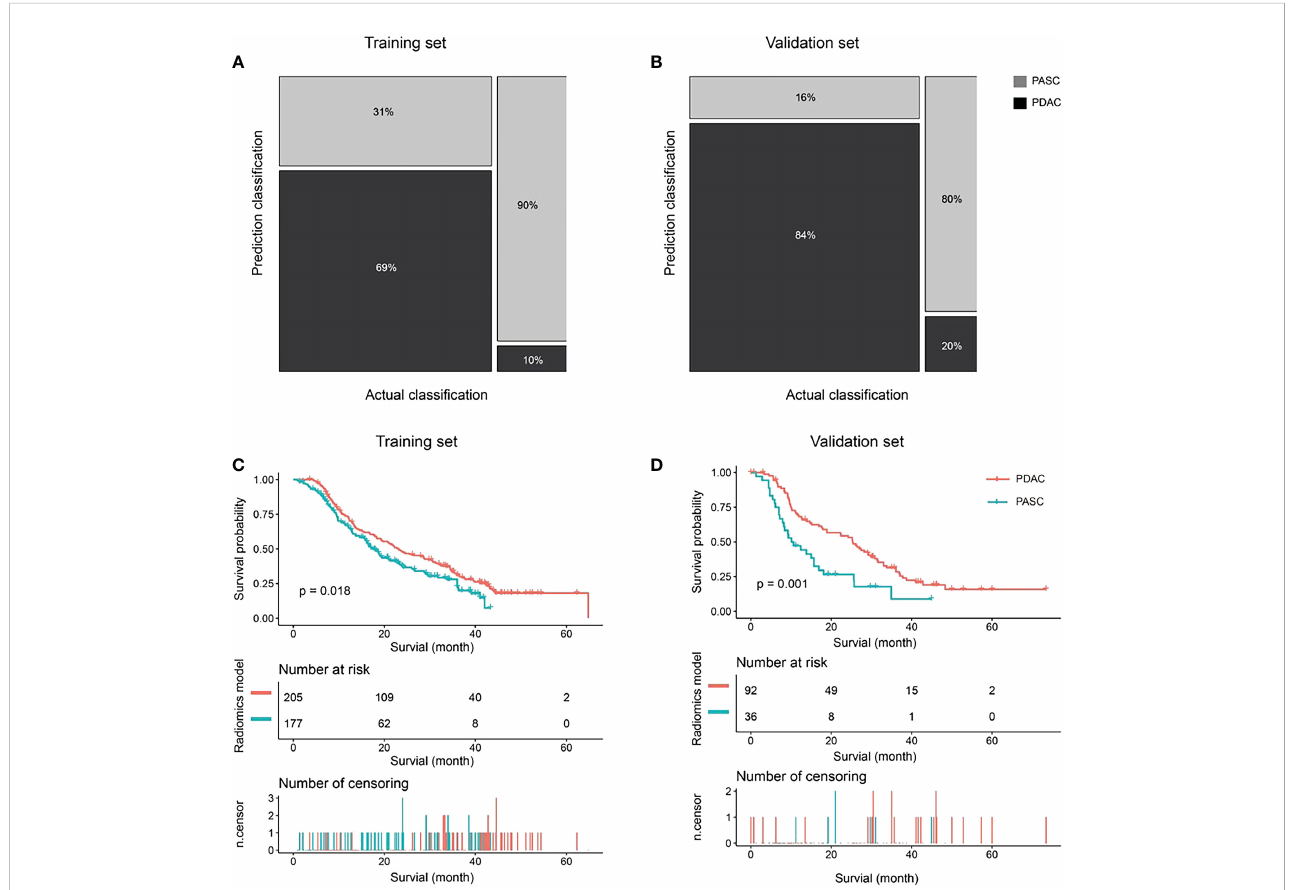
FIGURE 4 The classi fi cation and survival prediction of the radiomics model. (A) The mosaic plot of the training set. (B) The mosaic plot of the validation set. (C) The survival prediction of the radiomics model signi fi cantly shows longer survival for patients in the pancreatic ductal adenocarcinoma (PDAC) group than those in the pancreatic adenosquamous carcinoma (PASC) group in the training set. (D) The survival prediction of the radiomics model shows longer survival for patients in the PDAC group than those in the PASC group in the validation set signi fi